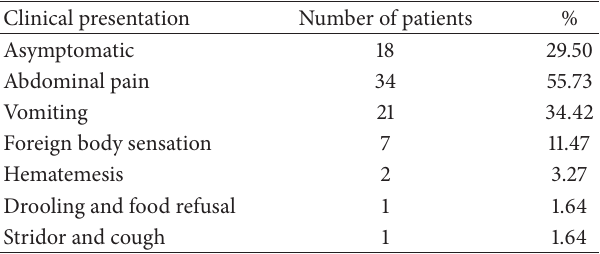
Table 1: Clinical symptoms in the patient series.